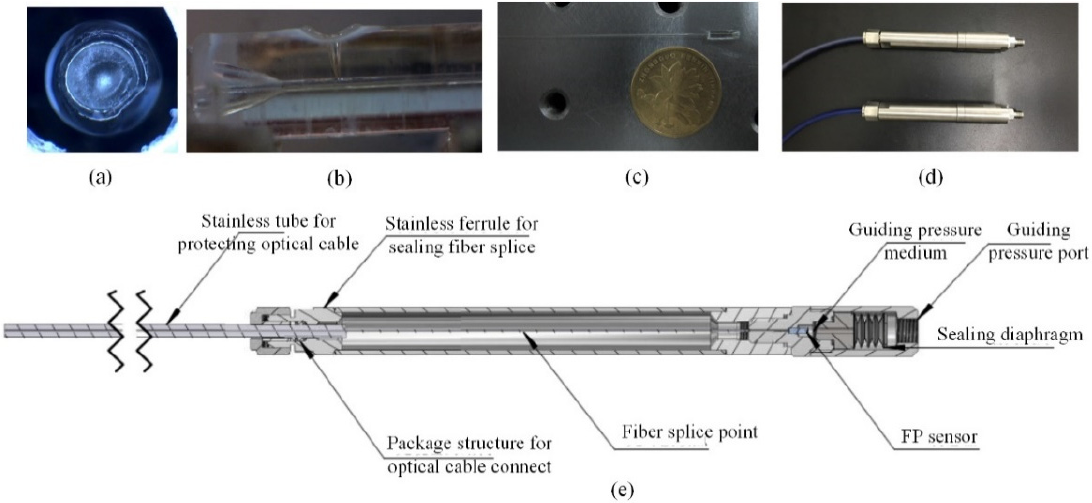
Figure 3. Laser-welded sensor head and sensor package. ( a ) physical photo of diaphragm after welded; ( b ) physical photo of ferrule after welded; ( c ) physical photo of welded sensor without package; ( d ) physical photo of packaged sensor; and ( e ) schematic diagram of sensor package.